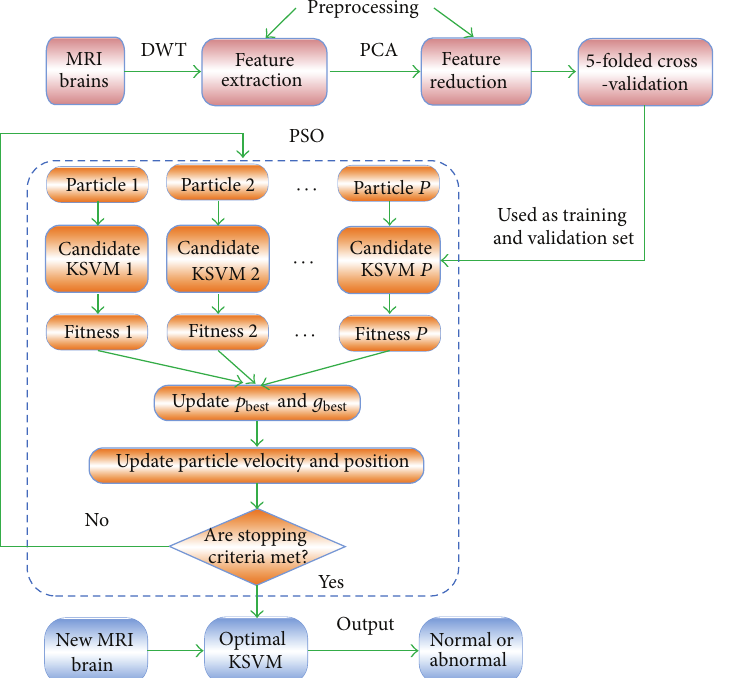
Figure 5: Methodology of our proposed PSO-KSVM algorithm.